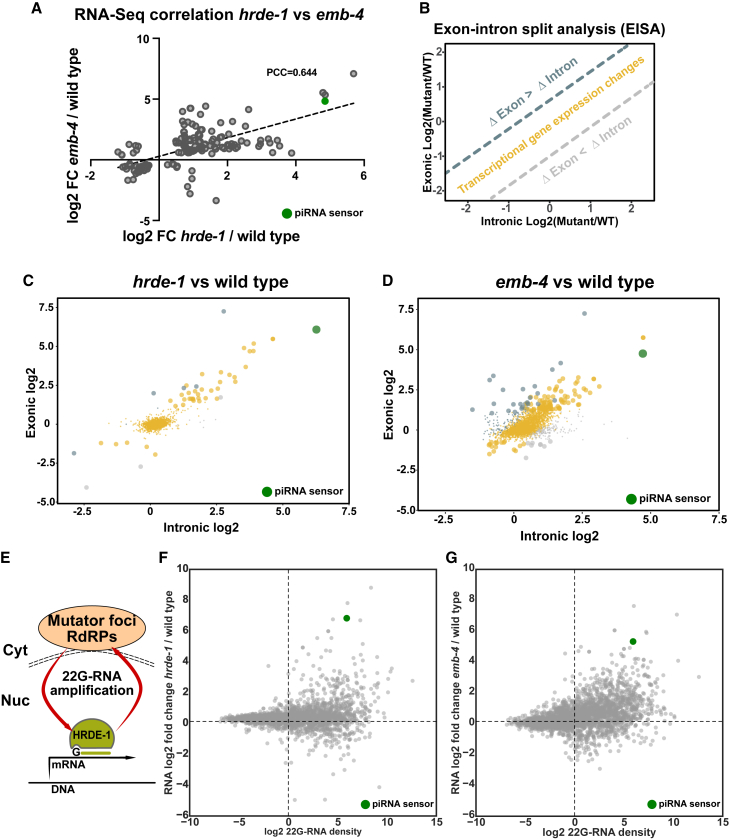
EMB-4 and HRDE-1 Are Required for Transcriptional Silencing of Genes and Transposable Elements(A) Log2 fold change values of genes, which show significant expression change (adjusted p ≤ 0.05) in both hrde-1 and emb-4 mutants (151 genes in total), are plotted against each mutant background (dashed line, linear fit curve; PCC, Pearson's correlation coefficient; green dot, piRNA sensor transgene).(B) Exon-intron split analysis (EISA) for comparison of transcriptional and post-transcriptional gene expression changes.(C and D) Transcriptional and post-transcriptional gene expression changes in hrde-1 (C) and emb-4 (D) are colored as in (B). Significant gene expression changes are highlighted by larger dot size (large dots denote mRNA log2 fold change ≥ 1, p ≤ 0.05). piRNA sensor transgene is highlighted by the green dot.(E) Model showing 22G-RNA amplification in mutator foci, which requires HRDE-1 for 22G-RNA transport and stability.(F and G) Comparison of RNA log2 fold change in hrde-1 and emb-4 mutants with log2 22G-RNA density in wild-type animals (22G-RNA density = 22G-RNA count in HRDE-1 IP [wild-type]/RNA reads per kilobase per million mapped reads [wild-type]). piRNA sensor transgene is highlighted by the green dot.See also Figure S5.